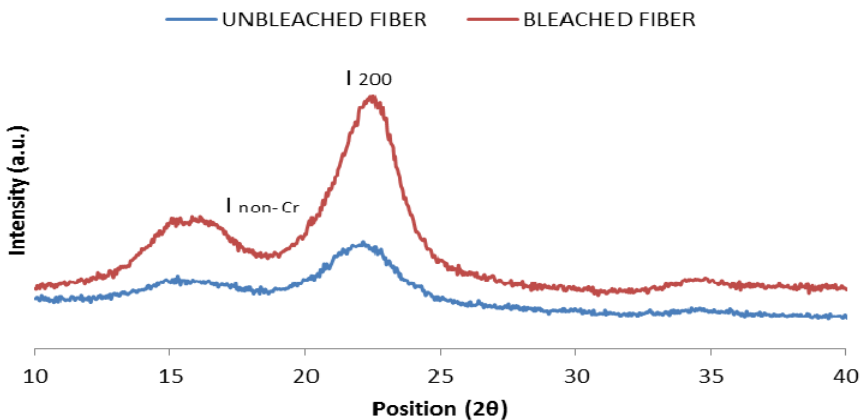
Figure 3. XRD patterns of unbleached and bleached